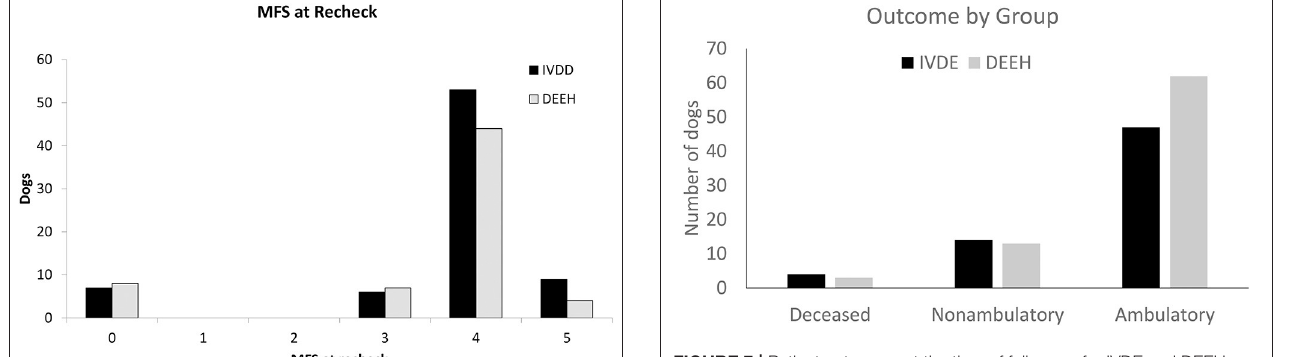
FIGURE 7 | Patient outcomes at the time of follow-up for IVDE and DEEH.